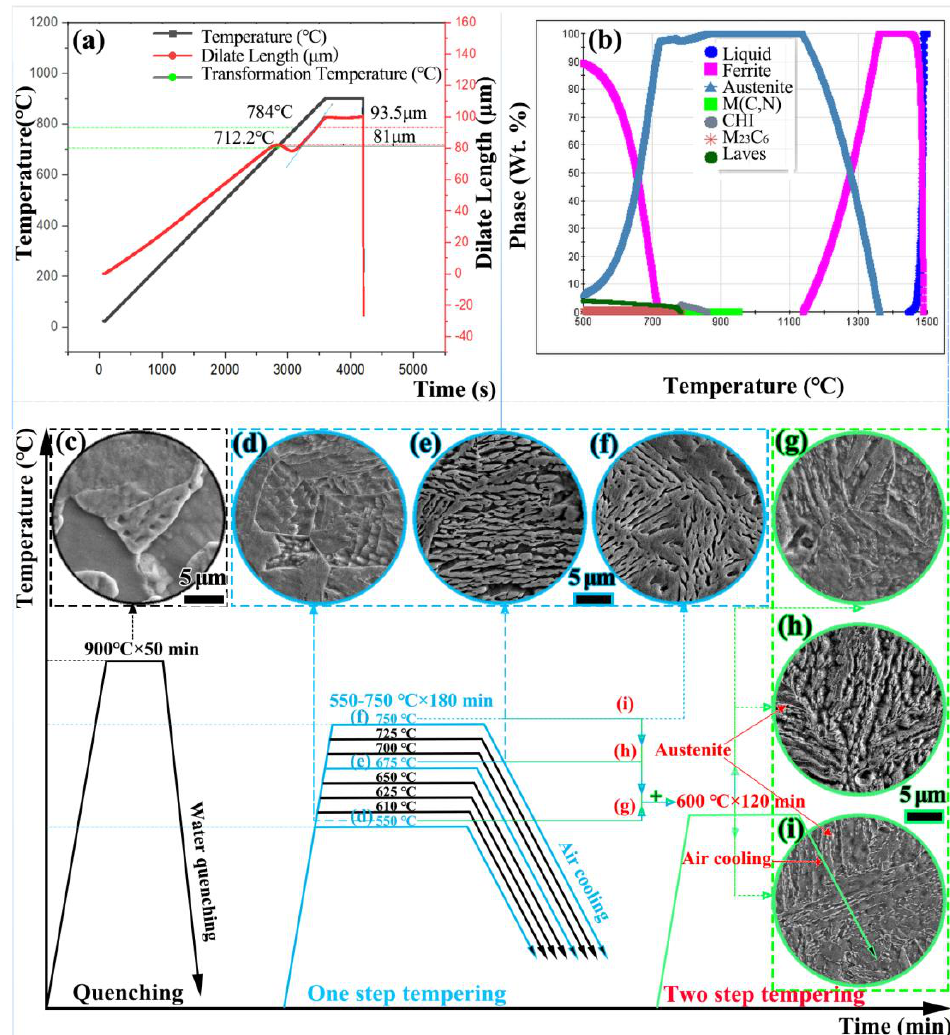
Figure 1. ( a ) Thermal dilatometric curve; ( b ) equilibrium phase diagram; ( c – i ) microstructure evo- lution.